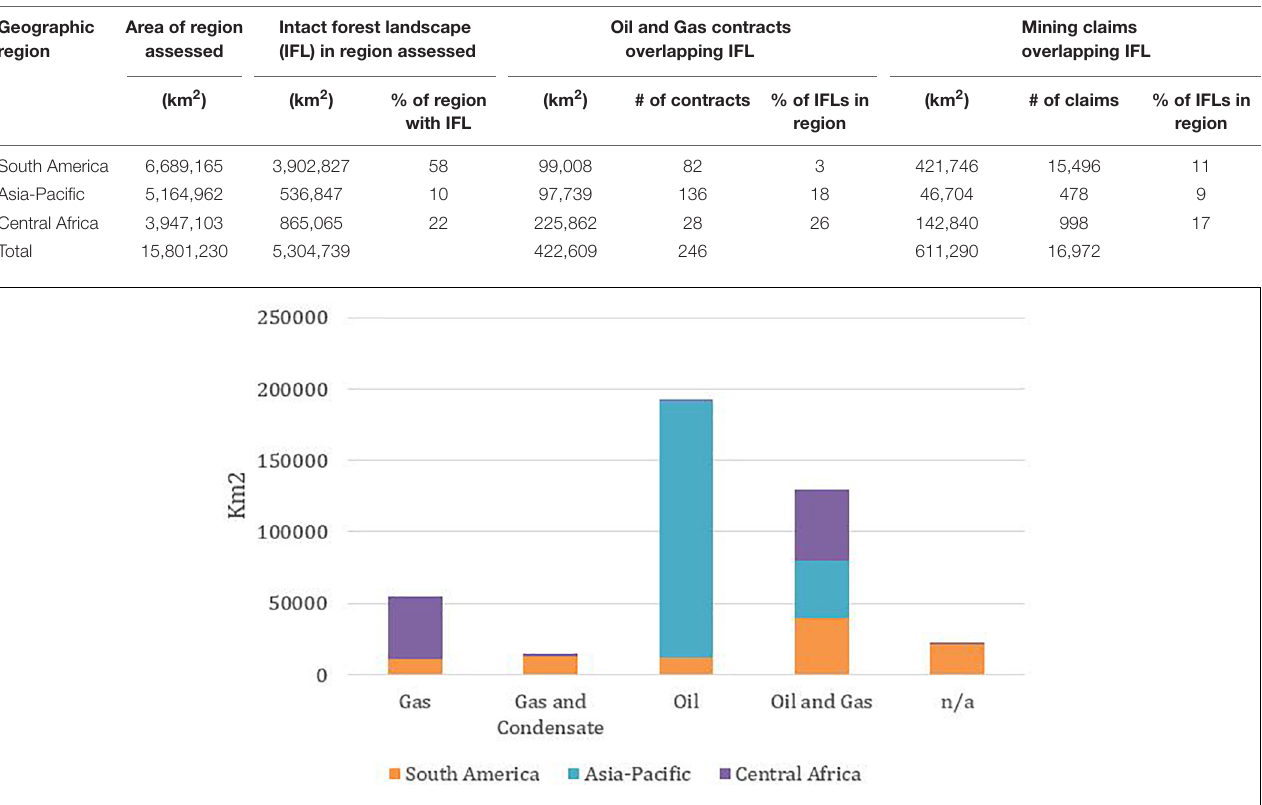
FIGURE 3 | The type of oil and gas operation where oil and gas contracts overlap IFLs.